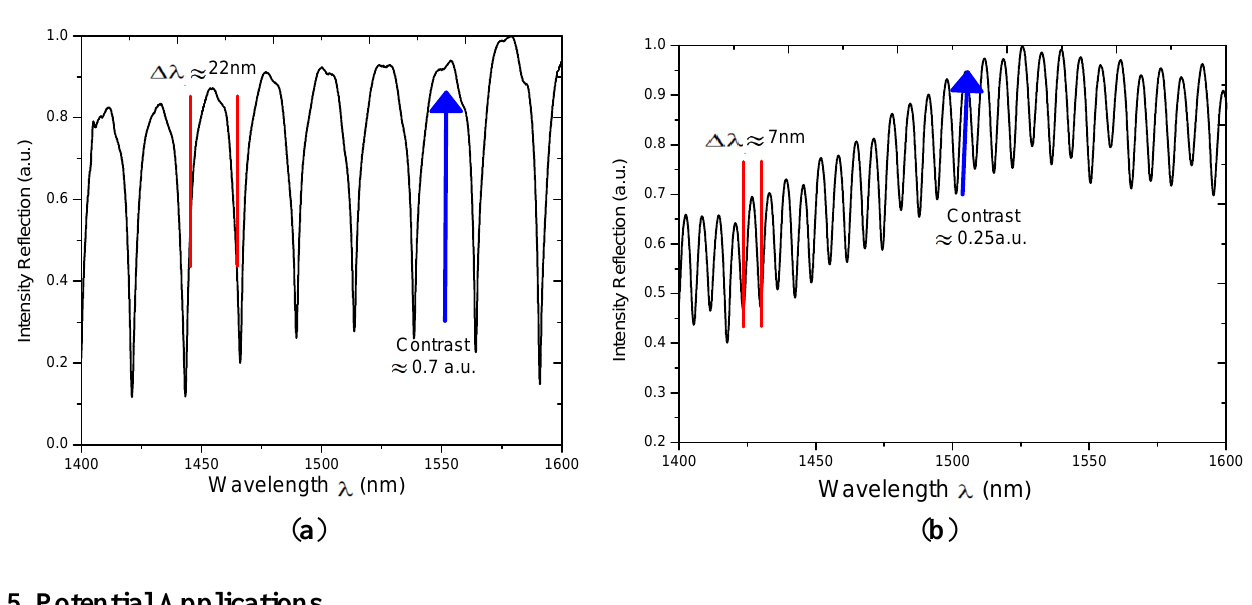
Figure 6. Measured spectrum reflection of two IFPI fabricated using = 200